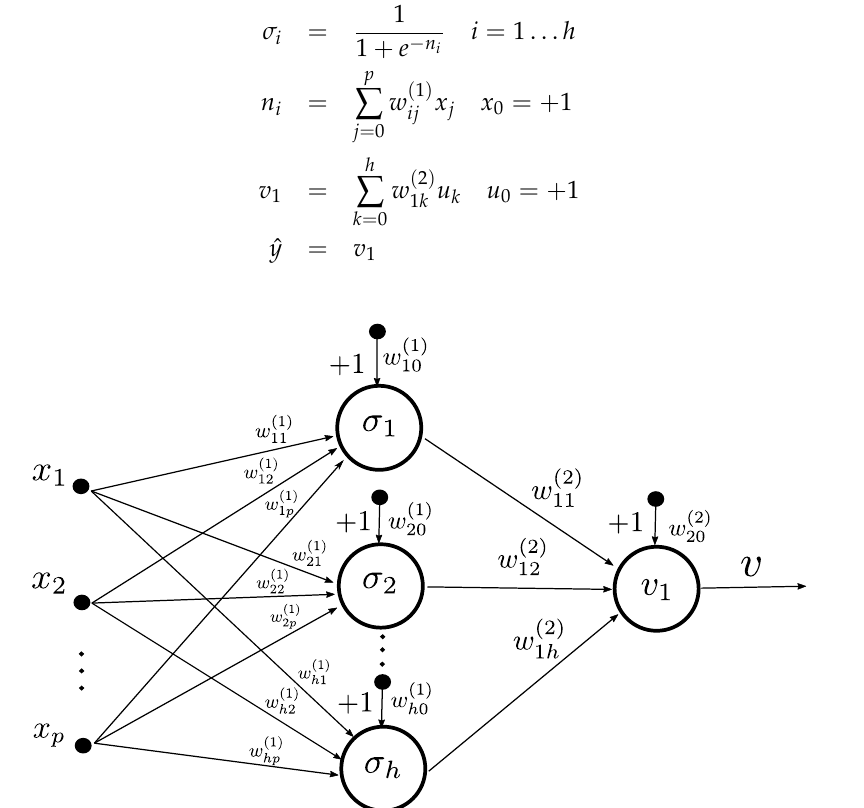
Figure 5. Multilayer Perceptron architecture. The networks has p inputs and h nodes in the hidden layer. the weights from the input layer to the hidden layer are denoted by w the hidden layer to the output layer are described by w